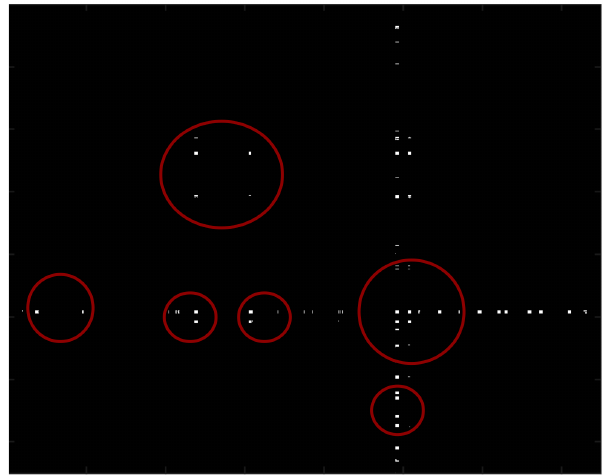
Figure 4. Detection of changes and regions of distinguished activity in Gnutella snapshots of two consecutive days [34,35] with Ricci flow and a parameter choice of K = 10 and thresh = 0.8 (the relatively small number of iteration steps was chosen for the sake of computation time). The figure shows a heat map of the correlation matrix of the edges’ Ricci-curvature. Highlighted spots correspond to single edges and assortments of edges and nodes (clusters) with high activity